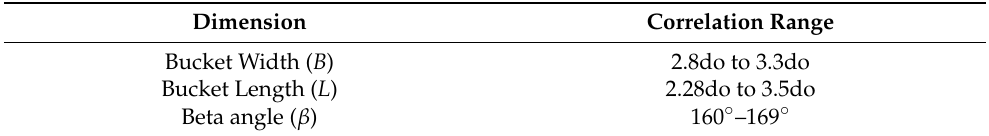
Table 4. Correlations of Pelton bucket